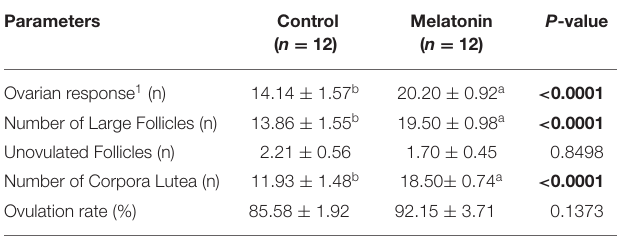
TABLE 1 | Effect of melatonin treatment (mean ± SE) with the superovulatory responses under heat stress condition. Parameters